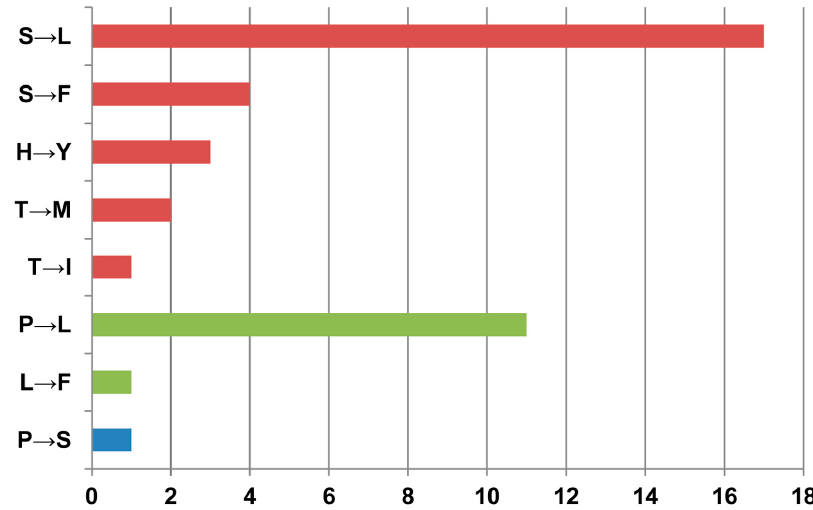
Figure 2. Types and quantities of amino acid exchanges arising from chloroplast RNA editing in Ae. tauschii (AL8/78). The red bars represent a conversion of amino acid from hydrophilic to hydrophobic, while blue is for the opposite direction and green is for no hydrophobicity exchanges.